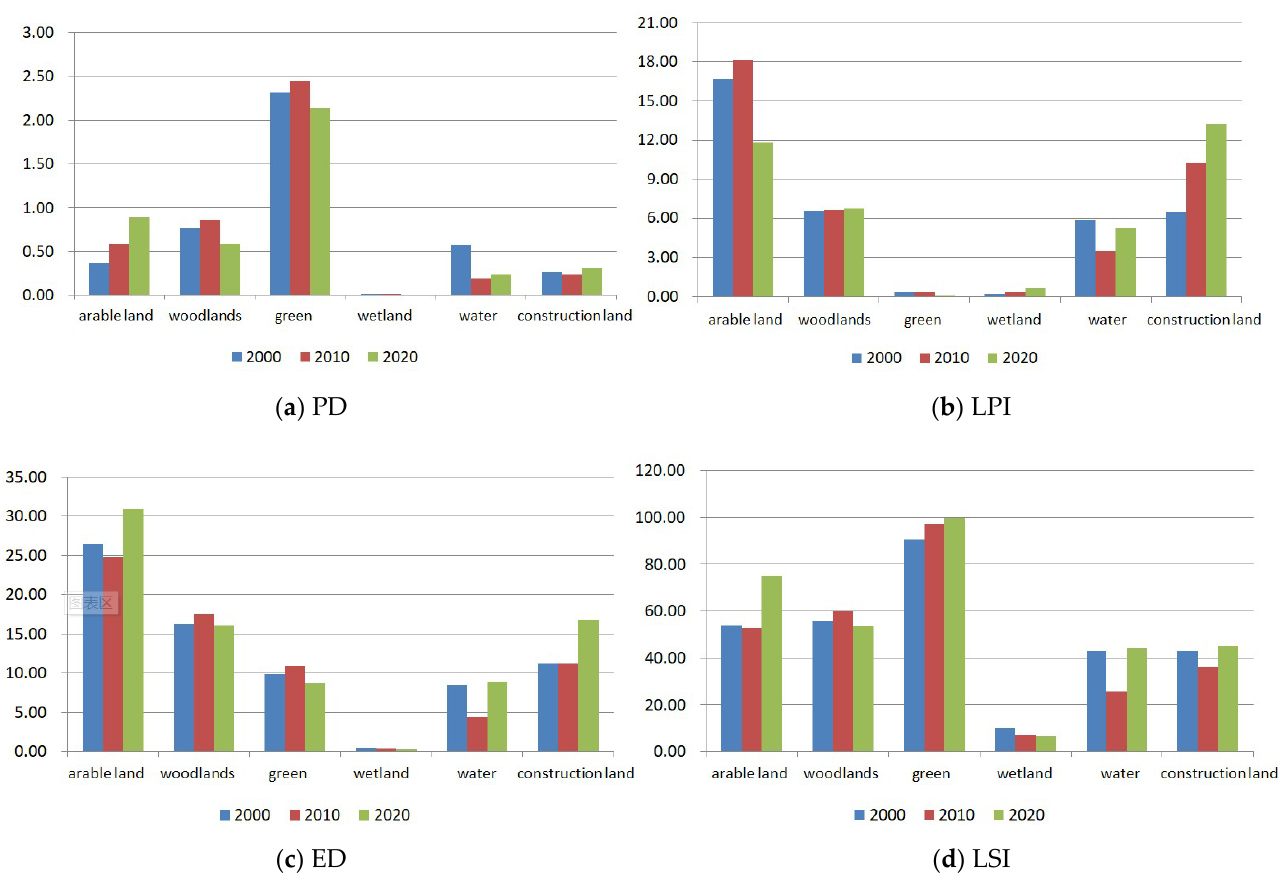
Figure 3. Evolution of landscape index at patch level in the main districts.